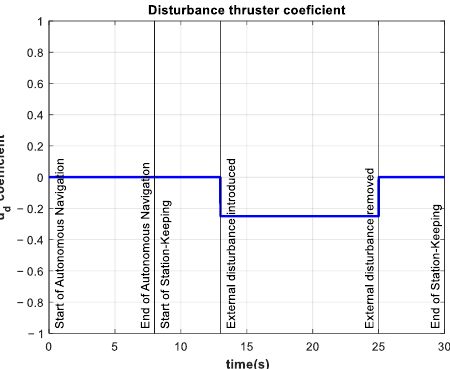
Figure 15. Additional thruster coefficient of −0.25 in the interval 13 s ≤ 𝑡 ≤ 25 s .